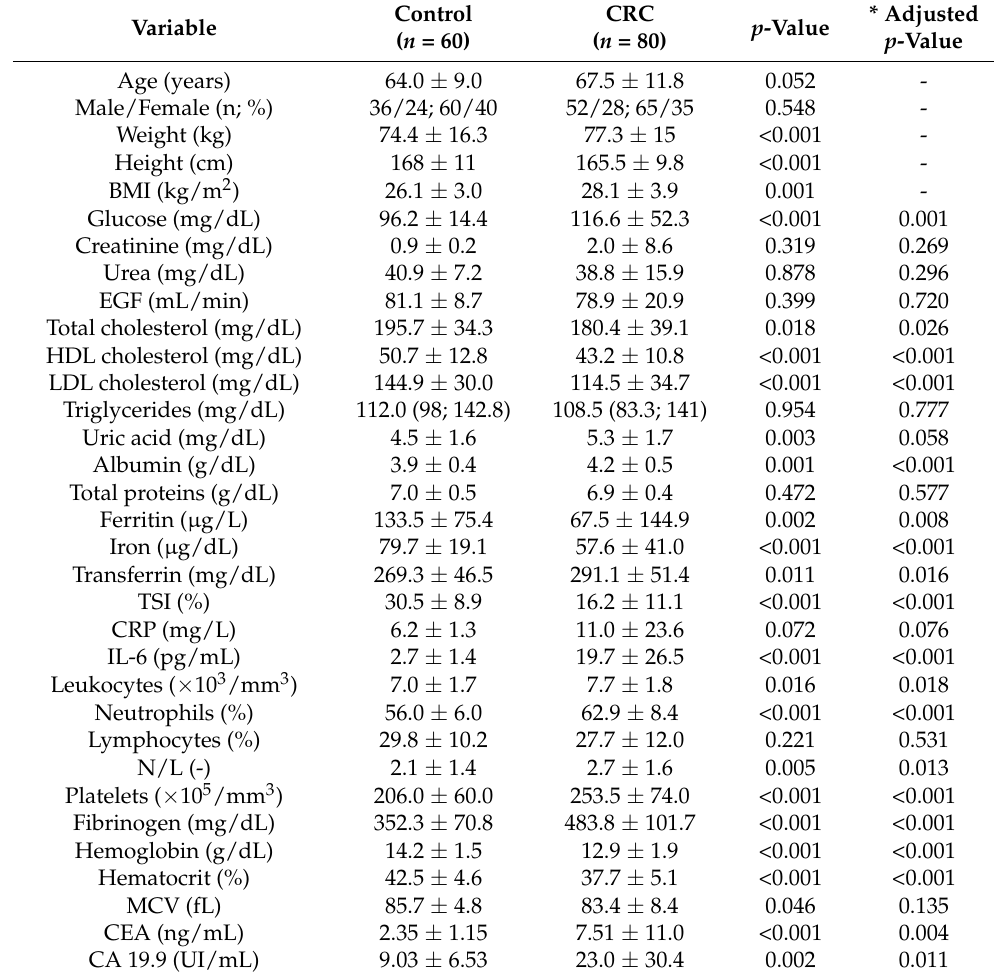
Table 1. Demographic, anthropometric, biochemical, anemia, inflammatory and tumor parameters of controls and colorectal cancer (CRC)